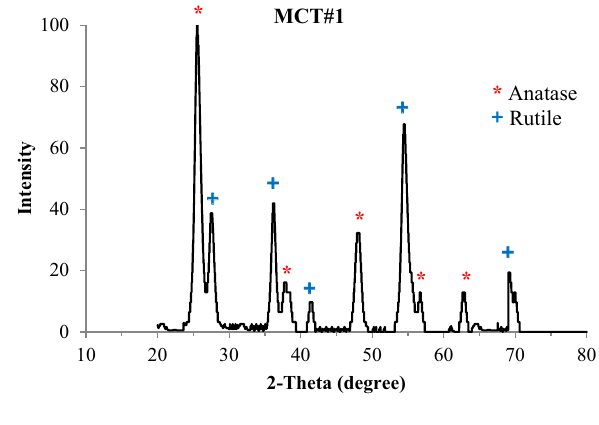
Fig. 1 XRD pattern of the synthesized MCT#1